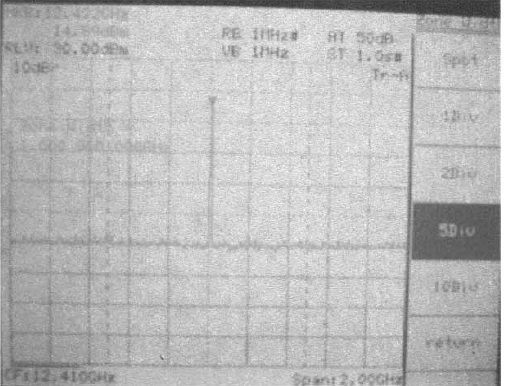
FIGURE 5 Measured spectrum of VCO with DGS. The bias conditions are V varactor ¼(cid:1) 10V, V GS ¼(cid:1) 1V, V DS ¼ 5V, and I DS ¼